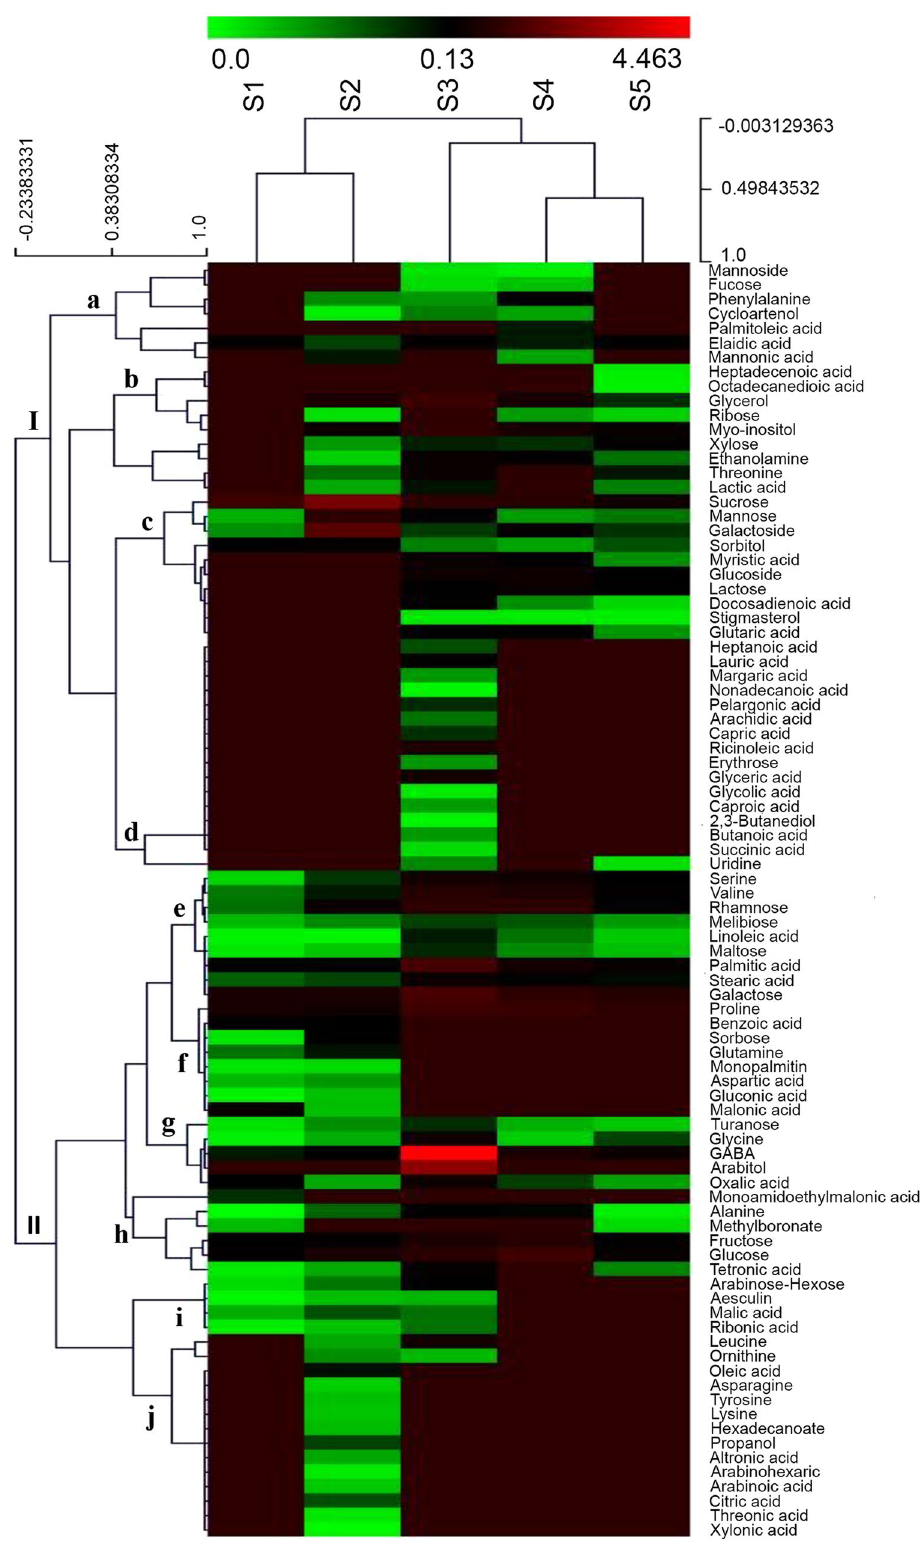
Figure 4. A hierarchically clustered heat map of the primary metabolite levels of 89 representative metabolites at different developmental stages of saffron corm. The relative values of each metabolite were normalized to the internal standard ribitol of each developmental stage and are provided in Table S1, Supplementary information. Dark green represents lowest accumulation while the highest accumulation is depicted as dark red. S1–S5 refers to the five developmental stages of Crocus